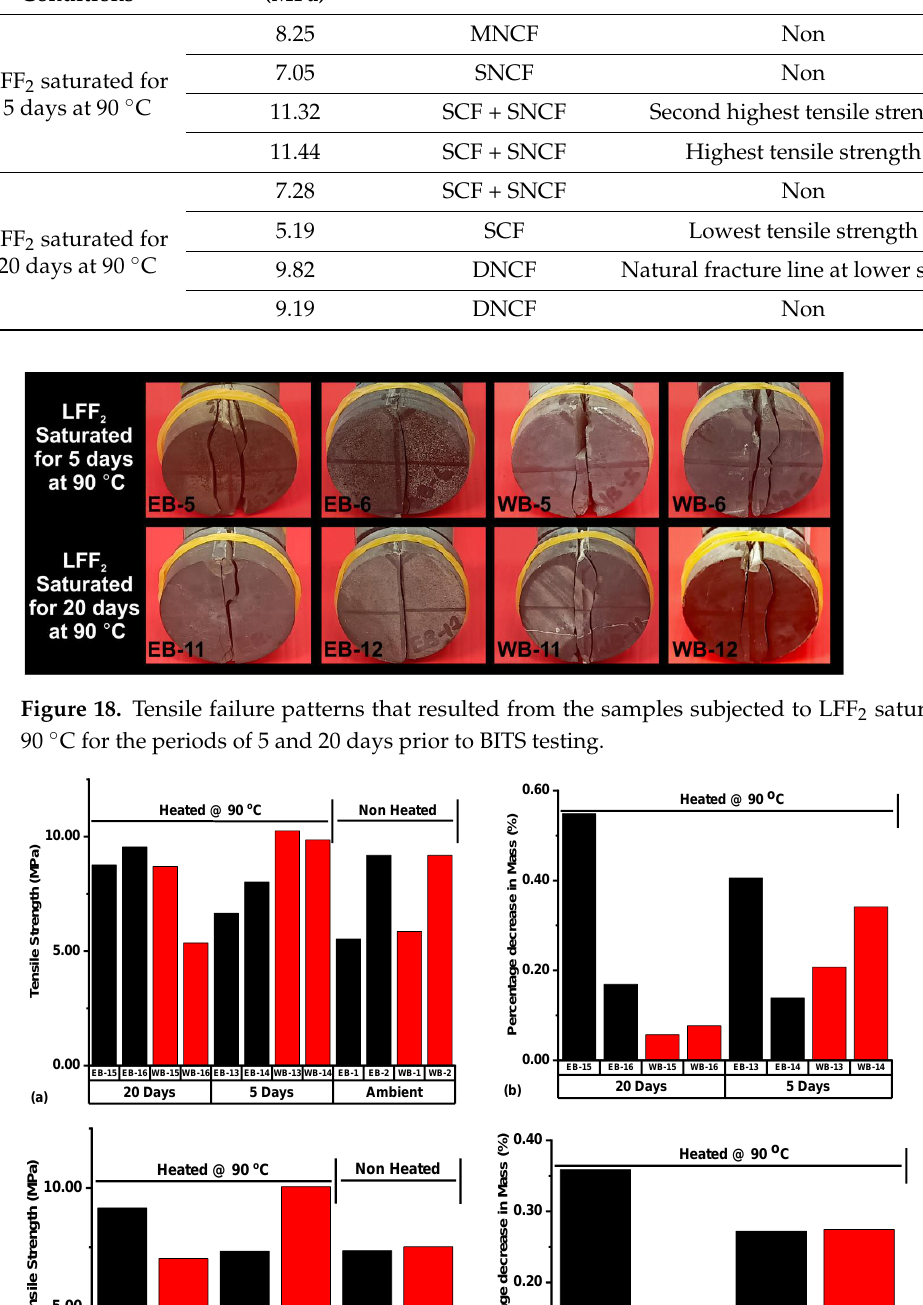
Table 2. Tensile failure analysis of samples subjected to LFF 2 saturation at 90 °C for the periods of 5 and 20 days prior to BITS testing. Identified failure patterns included SCF, SNCF, DNCF, and MNCF.